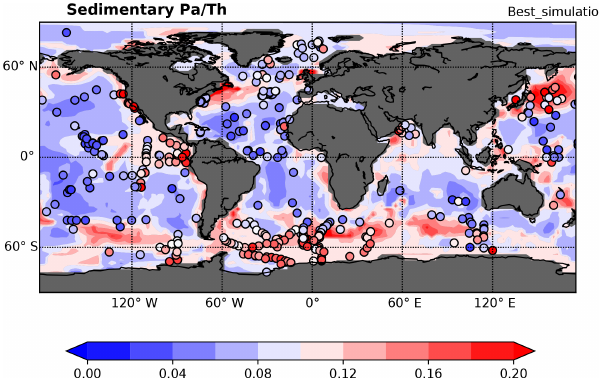
Figure 1. Map showing the particulate 231 Pa / 230 Th activity ratio of the deepest model ocean grid cells. The simulated Pa / Th ratio is represented in the colour background. The observations compiled in van Hulten et al. (2018) and references therein are represented as